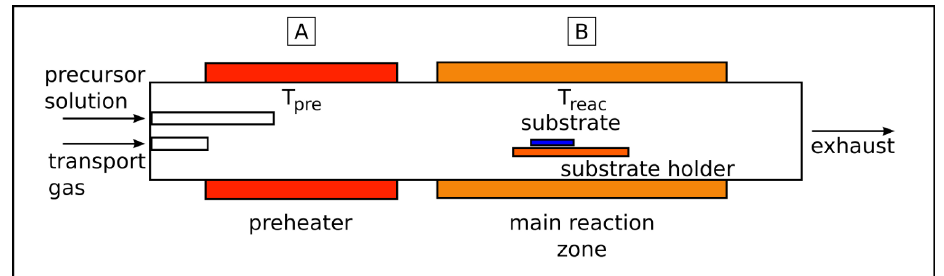
Figure 3. Setup of an aerosol experiment. The precursor solution is introduced by a nozzle and diluted by a transport gas flow. The solution evaporates in the preheater zone at temperature T . In the reaction zones both the hydrocarbon and the metallocene decompose pre at temperature T to form the reac